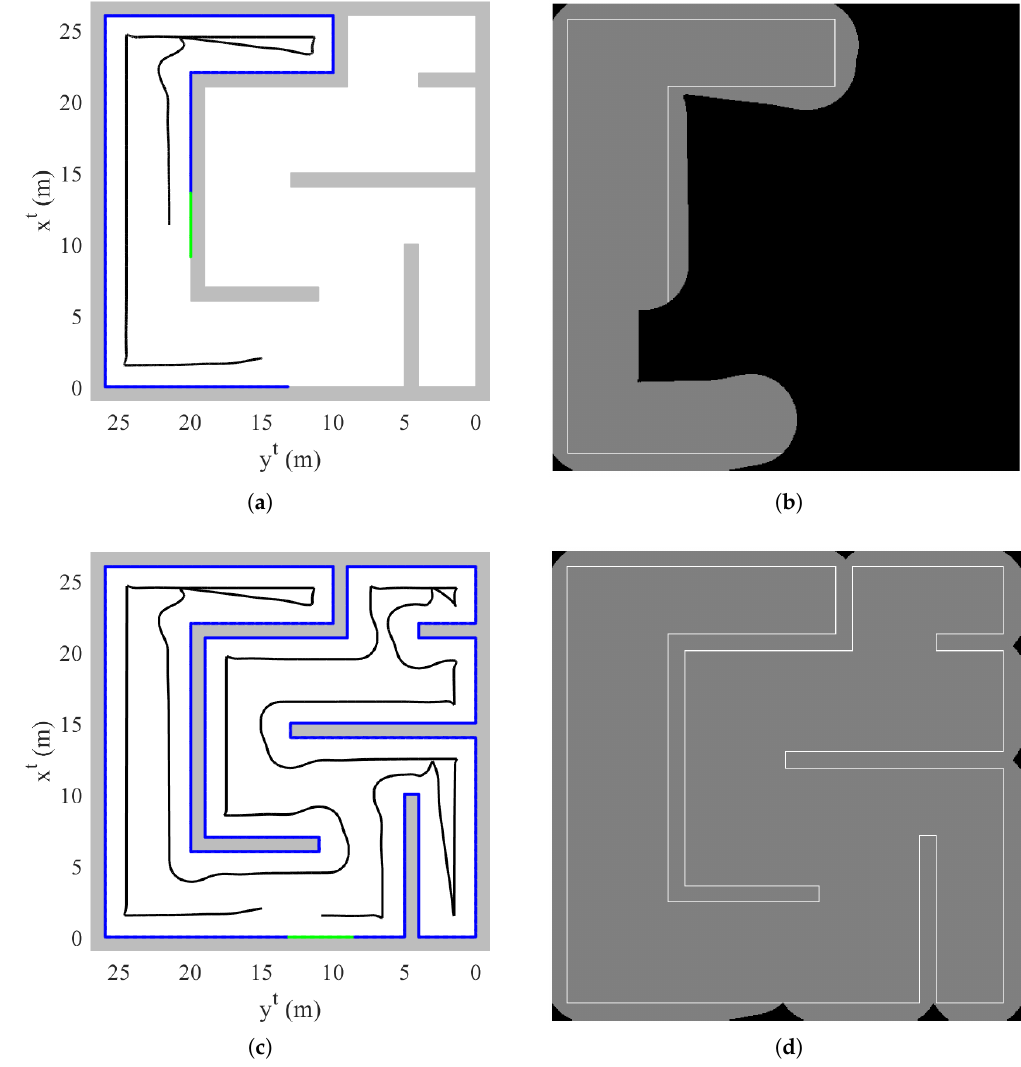
Figure 10. Simulation III result: ( a ) trajectory of the quadrotor and mapping at t = 98.0 s (top view, tangent–plane coordinate system); ( b ) discovered area at t = 98.0 s; ( c ) trajectory of the quadrotor and mapping at t = 318.4 s (top view, tangent–plane coordinate system); ( b ) discovered area at t = 318.4